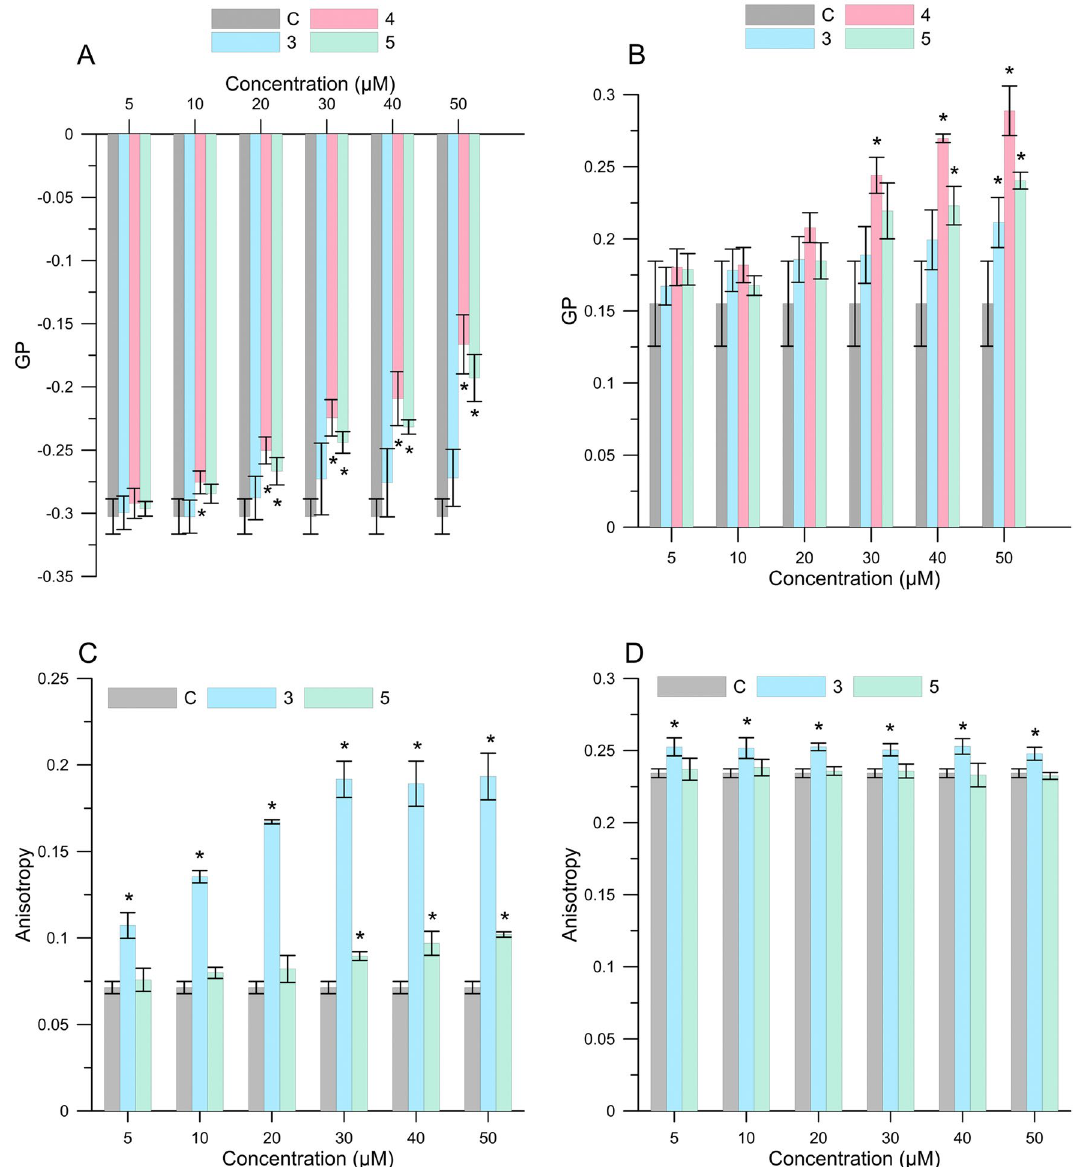
Figure 2. GP of Laurdan probe for ( A ) PC and ( B ) RBCMs membranes in the presence of compounds (3), (4) and (5). Anisotropy fluorescence of DPH probe for ( C ) PC and ( D ) RBCMs membranes in the presence of compounds (3), and (5). Means labeled with asterisk (*) are significantly ( p < 0.05) different from control. PC- phosphatidylcholine liposomes, RBCMs-red blood cells membranes. C—control, (3) 2 ′ -hydroxy-4- methylchalcone(4) 4 ′ -methylflavanone, (5) 4 ′ compounds was close to the control after 1 and 24 h of incubation. However, after 48 h of incubation, a slight increase in the percentage of hemolysis for erythrocytes modified by flavonoids was observed, in particular for compound ( 5) . The increase observed in the amount of hemolyzed cells in the presence of compounds ( 5 ) was negligible and did not exceed 3.4% (± 0.61) for 100 μM concentration. This means that the tested compounds are not toxic.The compounds are considered to be slightly toxic when they achieve hemolysis above 10%, toxic when hemolysis is above 50%, and highly toxic with hemolysis exceeding 90% 19, 20 . These results are compatible with the hemolytic activity studies conducted by Cyboran et al. for green tea supplement (GP), epigallocatechin- 3-gallate (EGCG), and gallic acid (GA), measured after 1, 2 and 3 h of incubation 21 . Only EGCG after 3 h of incubation caused a slight increase of hemolysis to 5% 21 . Pawlikowska-Pawlęga et al. showed that quercetin does not show a hemolytic effect on human erythoryce suspended in isotonic solution 22 . Moreover, it causes a protec- tive effect against hemolysis in hypotonic solutions. Furthermore, extracts of buckwheat or saskatoon, whose main ingredients are compounds from the group of flavonoids, does not cause cytotoxic effect 2,23 . Interesting research was also presented by Suwalski et al. who showed that, on the one hand, the significant protection of Ungi molinae aqueous extract in low concentrations is responsible for a considerable reduction in the deleterious